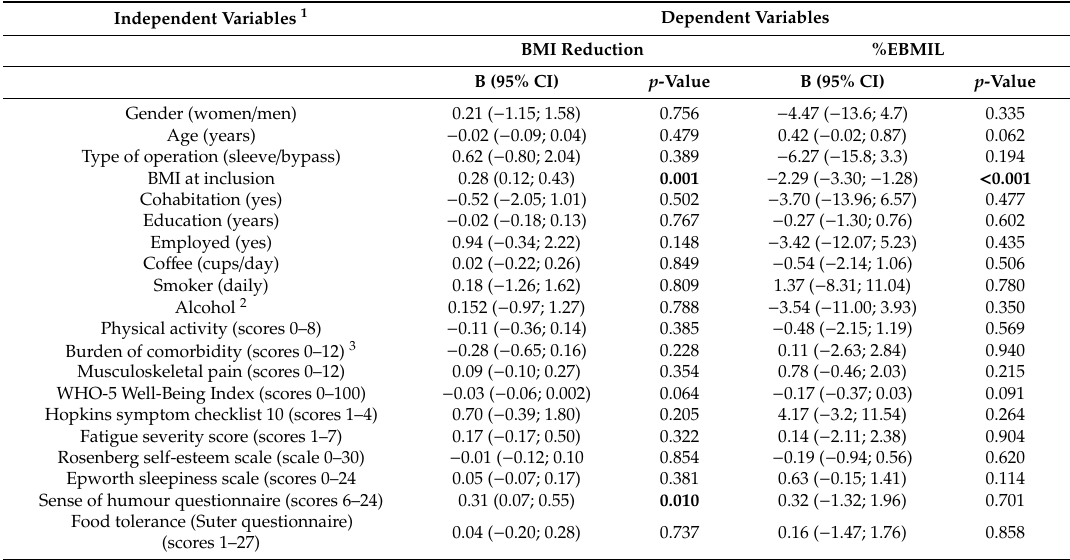
Table 3. Predictors of weight loss after combined behavioural and surgical interventions. Linear regression analyses with BMI reduction and %EBMIL from inclusion to six months after surgery were used as dependent